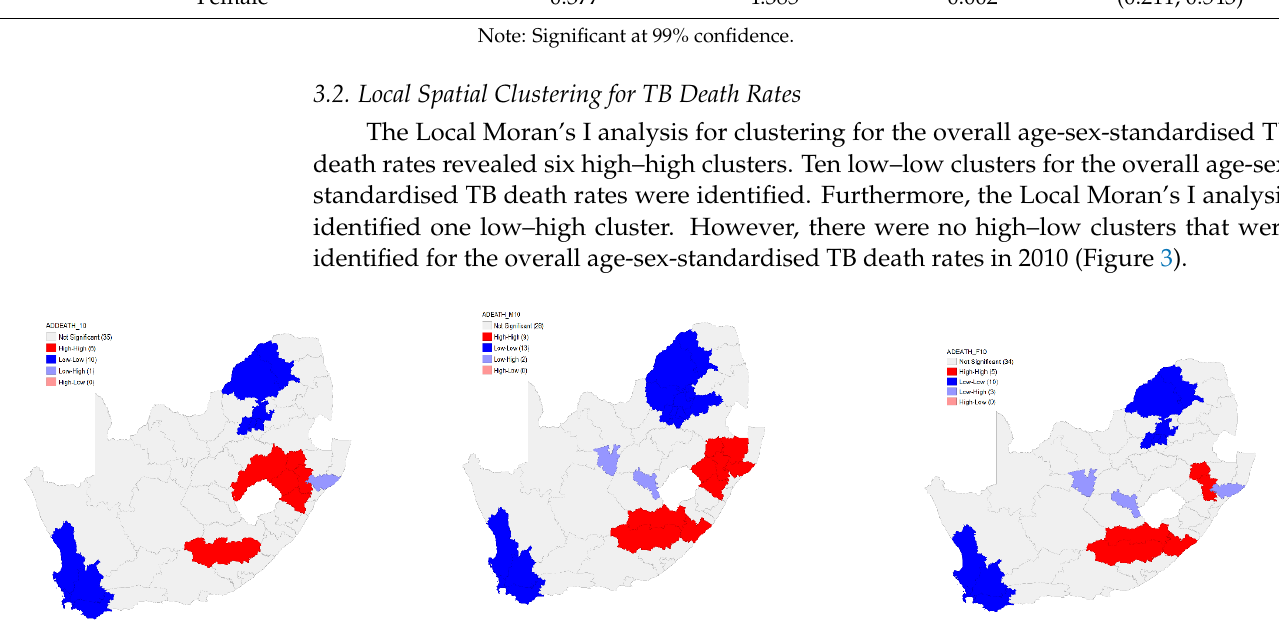
rates by district municipality,